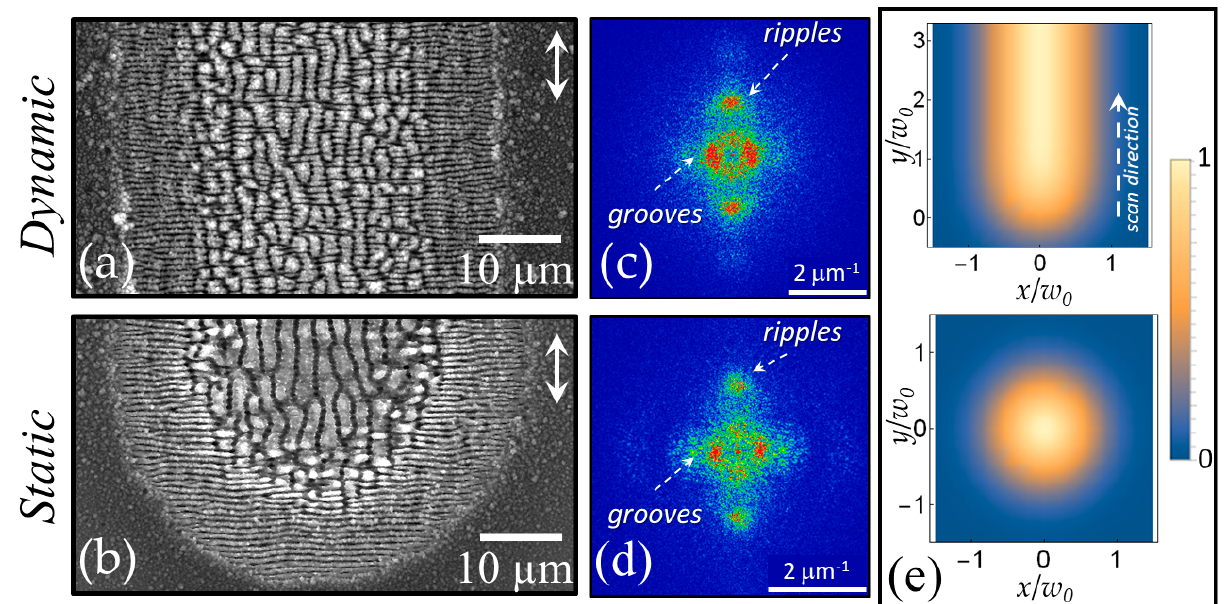
Figure 3. SEM images of the sample surface for ( a ) dynamic and ( b ) static irradiation configurations for surface structuring with laser pulses at 1026 nm with a duration of ≈ 180 fs. In both cases the laser peak fluence is F p = 0.4 J/cm 2 . The SEM image of panel ( a ) refers to dynamic irradiation conditions with a scan speed vs. of 0.25 mm/s and a pulse repetition rate f L = 1 kHz. The lower SEM image shows a portion of the crater generated in static irradiation conditions at the same peak fluence with N = 200 laser pulses. The double headed arrows indicate the direction of the laser beam polarization. Panels ( c ) and ( d ) report 2D-FFT maps corresponding to the SEM images obtained for dynamic and static irradiation conditions, respectively. Panel ( e ) displays the normalized fluence dose in the two cases.